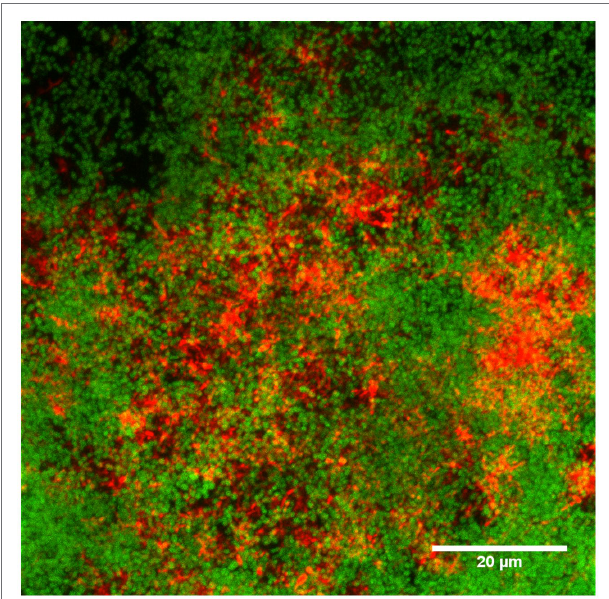
FIGURE 3 | Confocal laser scanning microscopy (CLSM) image of the FISH-stained two-species biofilm. Sixteen individual images with a z -step size of 1.018 μ m of the biofilm stained with species-specific 16S rRNA FISH probes for S.oralis (MIT447, green) and A.denticolens (ACT476, red) were overlaid to one image using ImageJ. Individual images are available in Supplementary Material